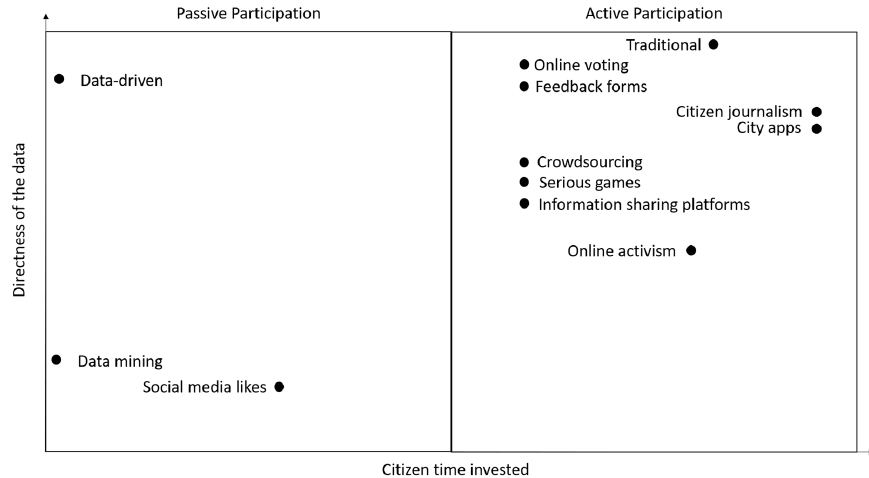
Figure 1. Active and passive public participation methods illustratively shown relative to the time